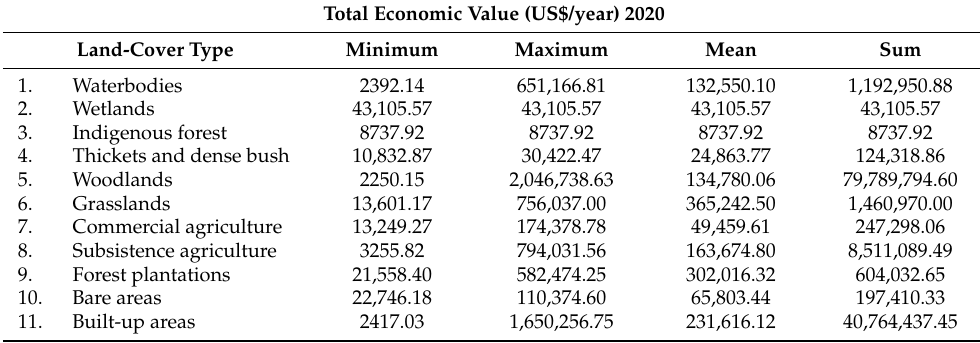
Table 4. Economic values summarised per land-cover